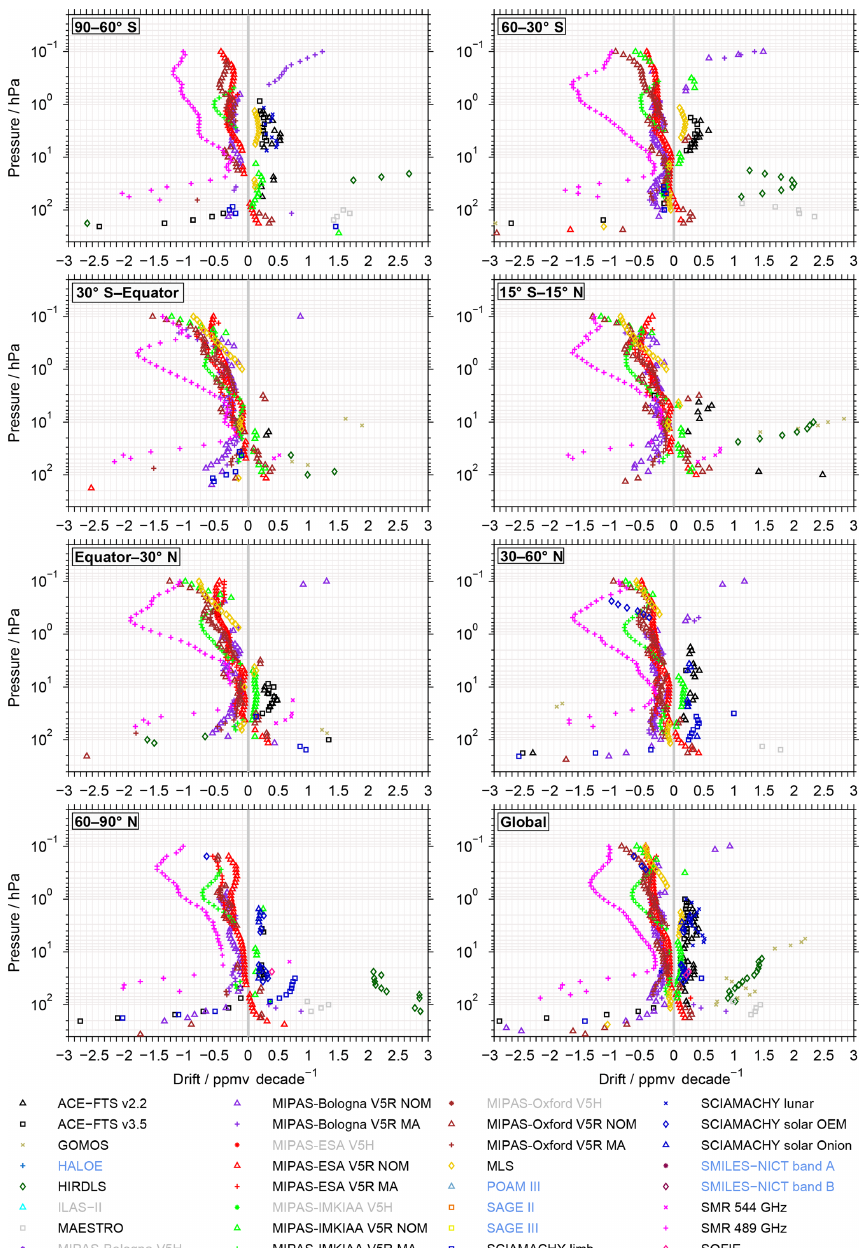
Figure 13. Drift summary for the MIPAS-ESA v7 data set. The summary shows only drifts that are statistically significant at the 2 σ uncer- tainty level and only results at every second altitude are plotted (as in Figs. 4 and 10). The different panels consider the results for different latitude bands. The legend lists all possible data sets. Whether they contribute results or not is indicated by different colours, as described in Sect.